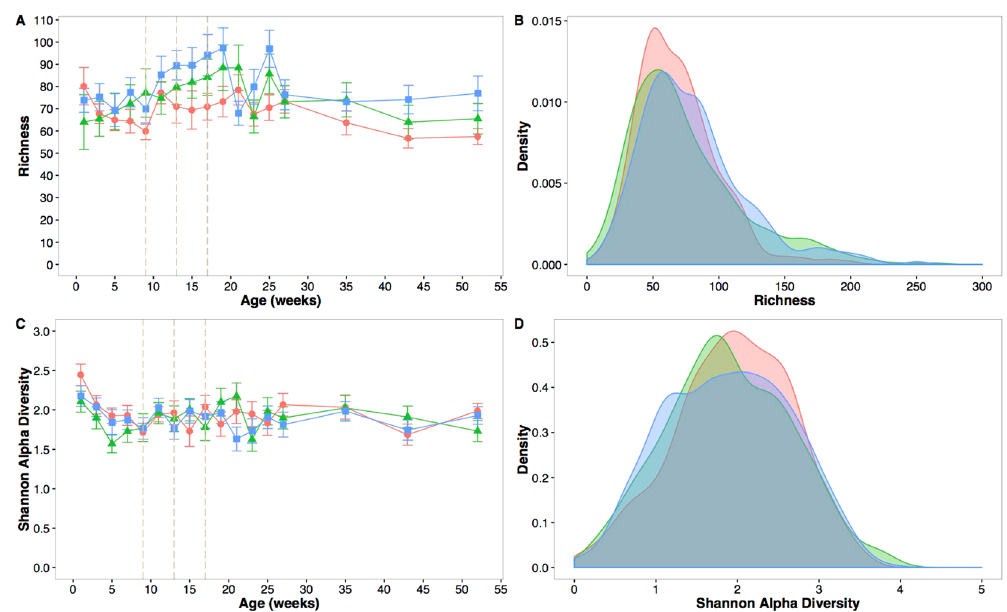
Figure 5. Nasopharyngeal microbiome richness and Shannon α -diversity in the first year of life by group. Richness over time ( A ); Density plot of richness ( B ); Shannon α -diversity in the first year of life ( C ); Shannon α -diversity in the first year of life ( D ). The vertical dashed lines are the study vaccination time points. The colour denotes the vaccination group; red for Group 1, green for group 2 and blue for